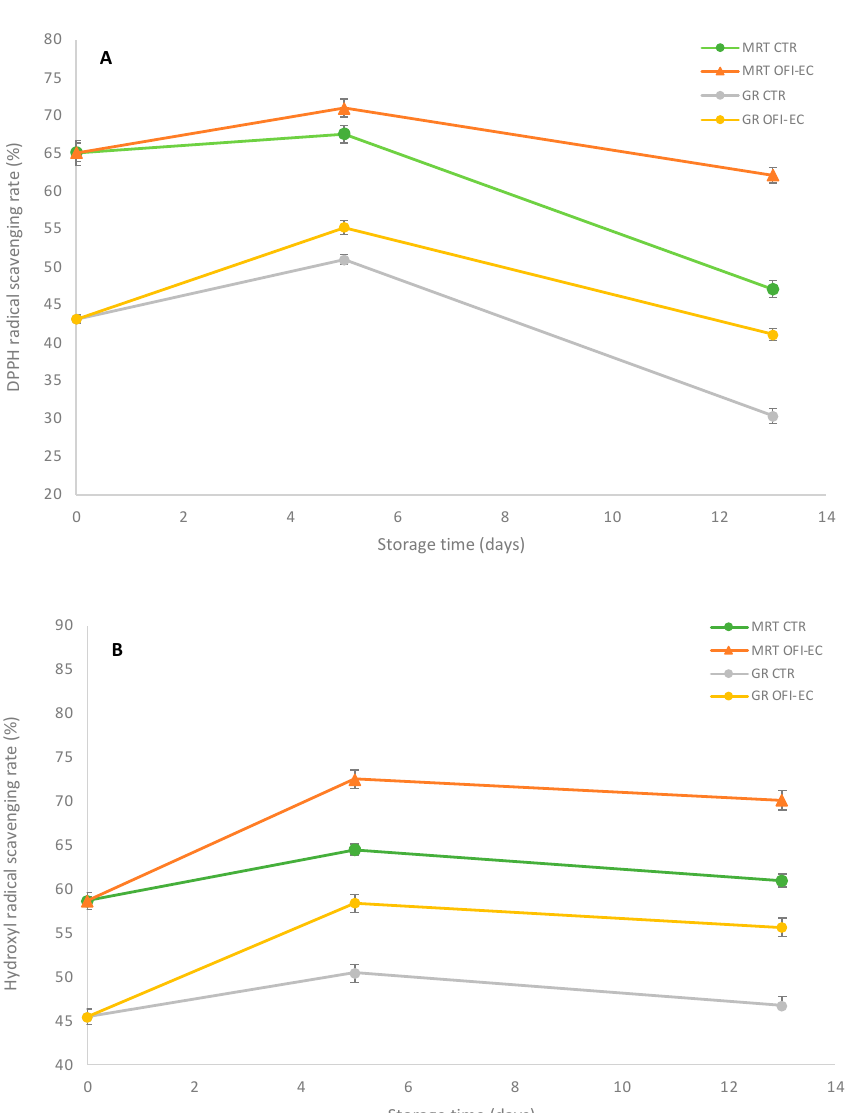
Table 3. Antibacterial activity of O. ficus-indica mucilage edible coating.